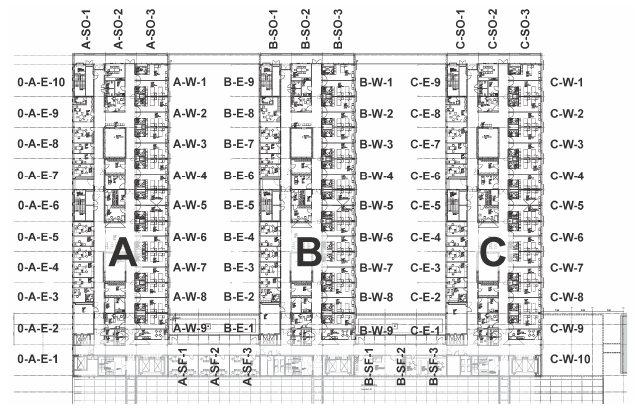
Figure 7. Project city hospital Northern Italy—ground floor with CUs.